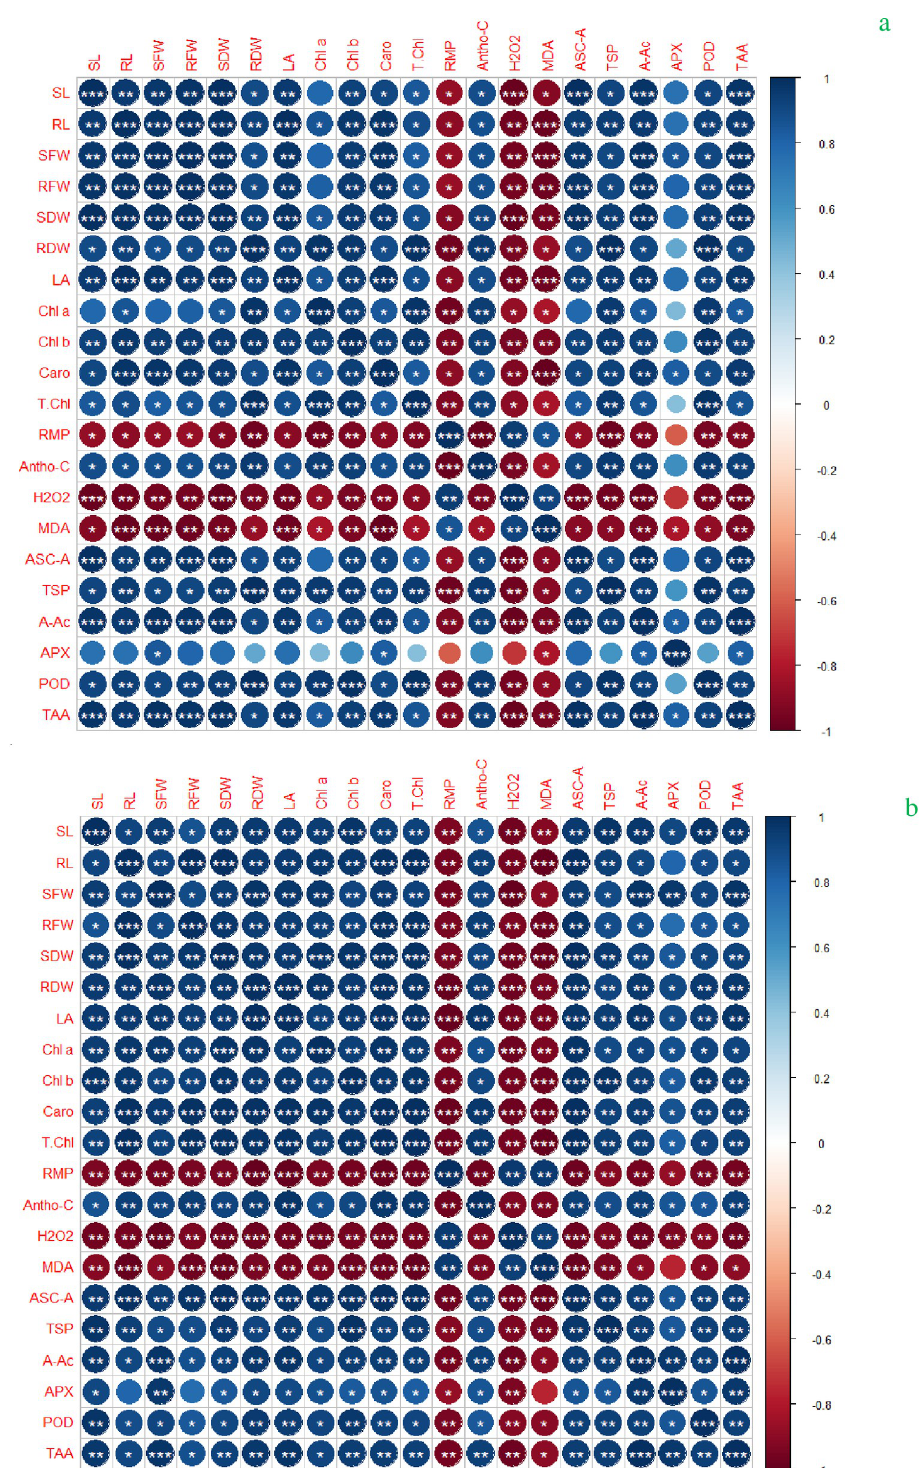
Fig 4. Correlation among morphological and physio-biochemical traits of maize seedlings under (a) under control and (b) Cd stress condition. Abbreviations are given at start of manuscript.